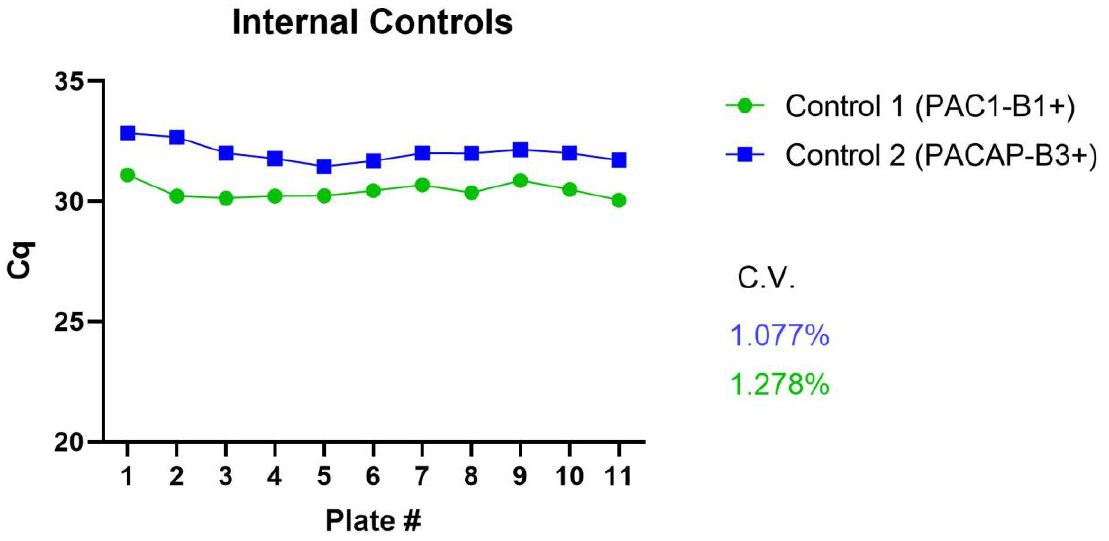
Figure A3. Coefficient of Variation Between Plates on Separate qPCR Runs. Inter-assay plate control trends with an associated coefficient of variation (C.V.). Data points represent the mean of technical replicates for each plate. Plate # refers to the number of independent qPCR plates performed for this